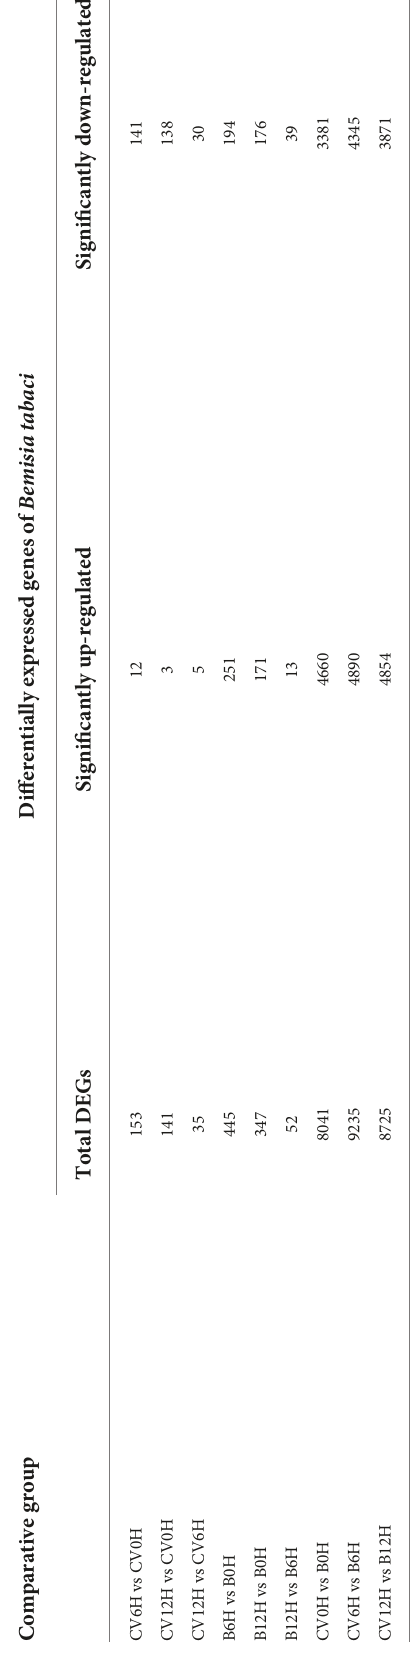
the clean reads from all treatments were mapped to trinity spliced transcriptomes at percentages ranging between 80.75 and 83.45%. The GC contents ranged between 39.46 and 44.49% ( Supplementary Table 4 ). Results of the unigene transcripts length distribution and NR-based comparison of mapped highest number (28,786) of unigenes were mapped to B. tabaci genome ( Supplementary Figure 2